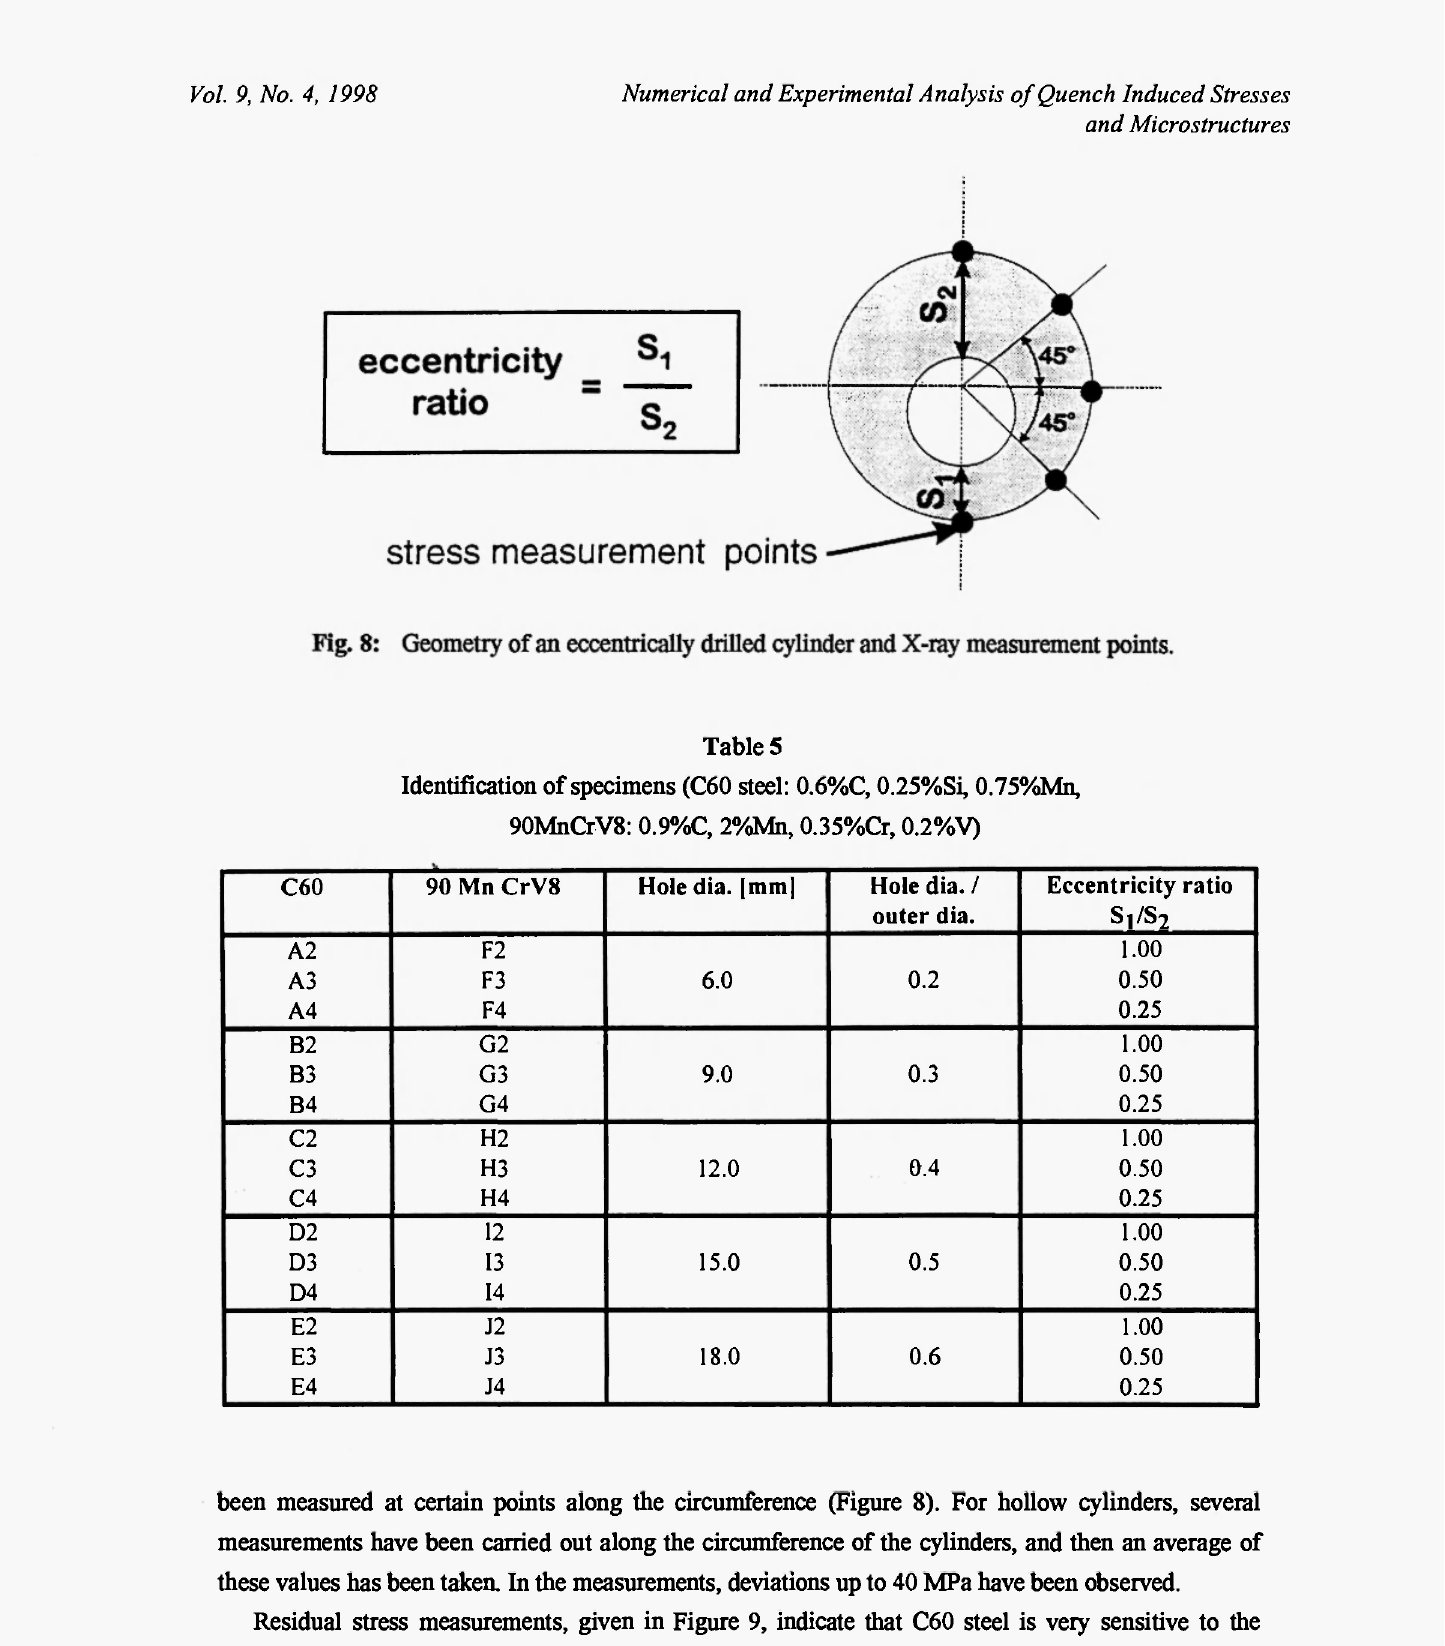
Identification of specimens (C60 steel: 0.6%C, 0.25%Si,